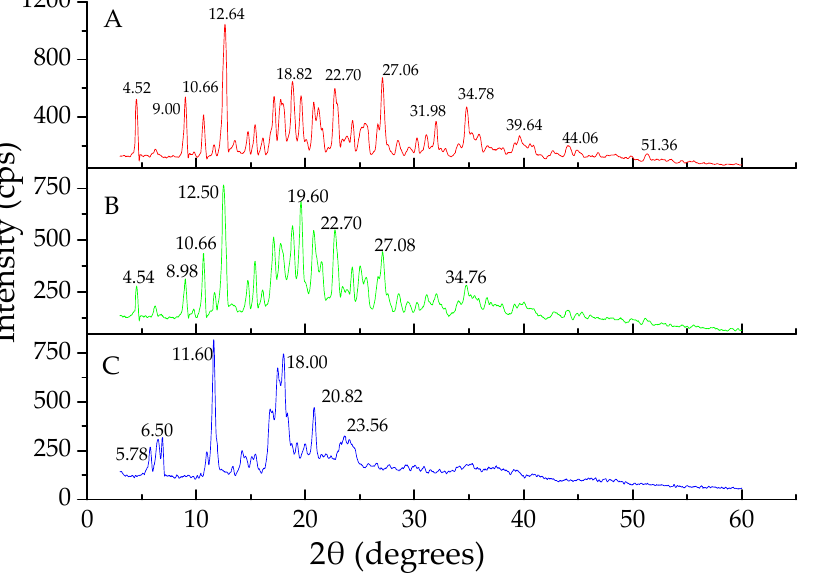
Figure 5. X-ray di ff raction patterns of β -CD ( A ), physical mixture ( B ), and the LCEO / β -CD inclusion Figure 5. X-ray diffraction patterns of β -CD ( A ), physical mixture ( B ), and the LCEO/ β -CD inclusion complex ( C complex ( C ).